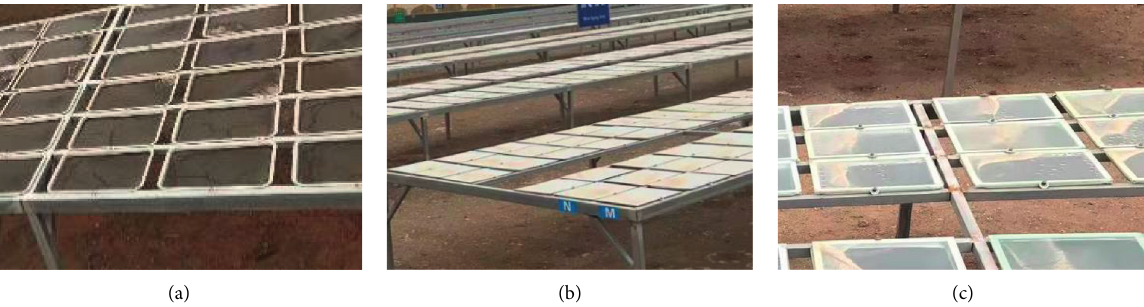
Figure 2: The natural aging test of asphalt binder. (a) All; (b) TO; (c) TO+UV.